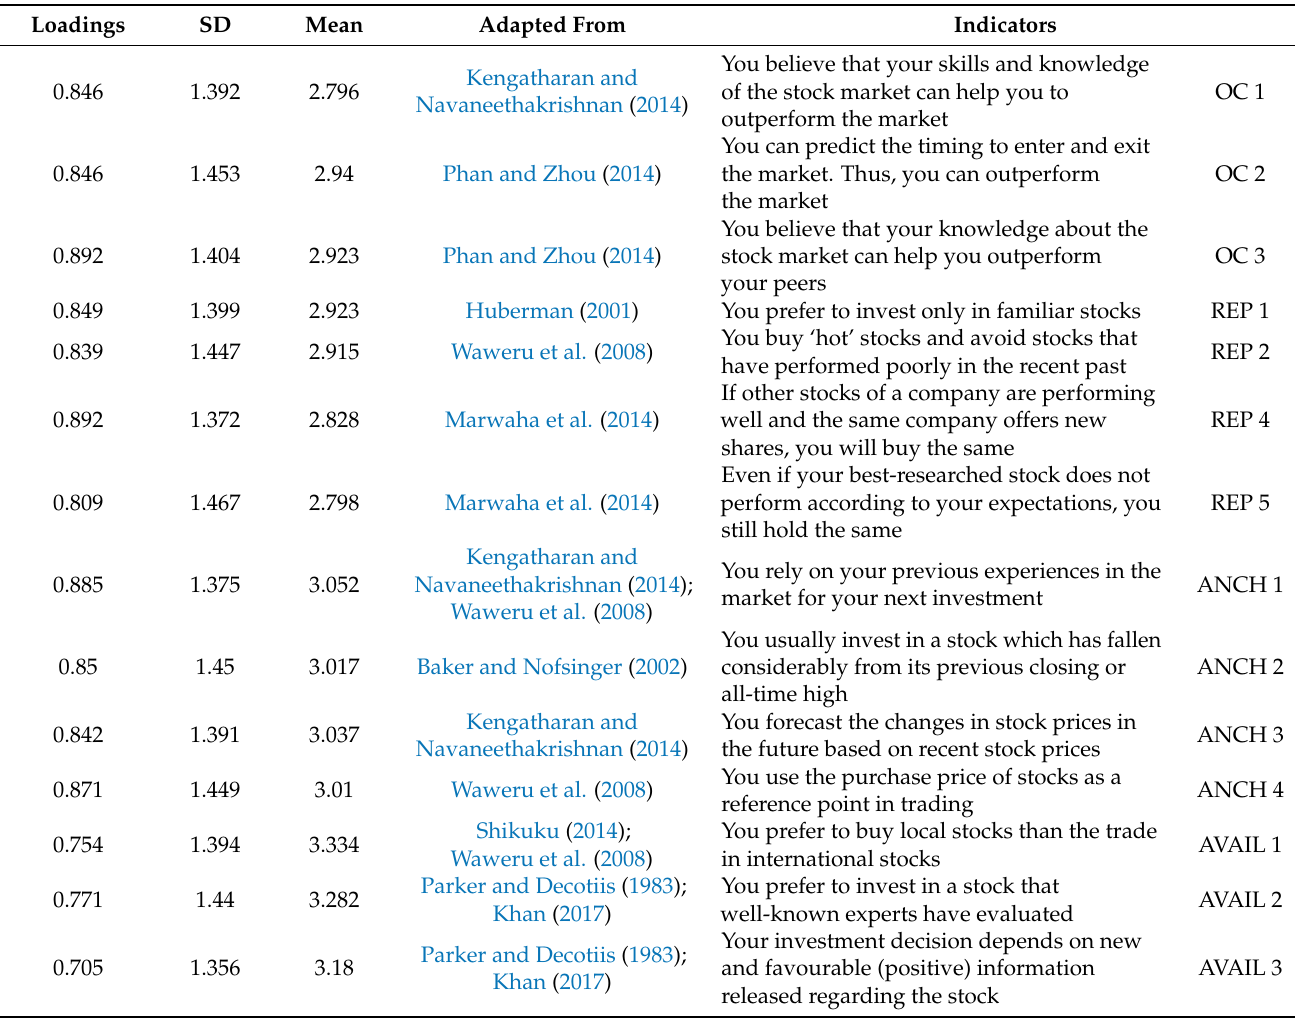
Table 1. Indicators, Mean, SD, and EFA